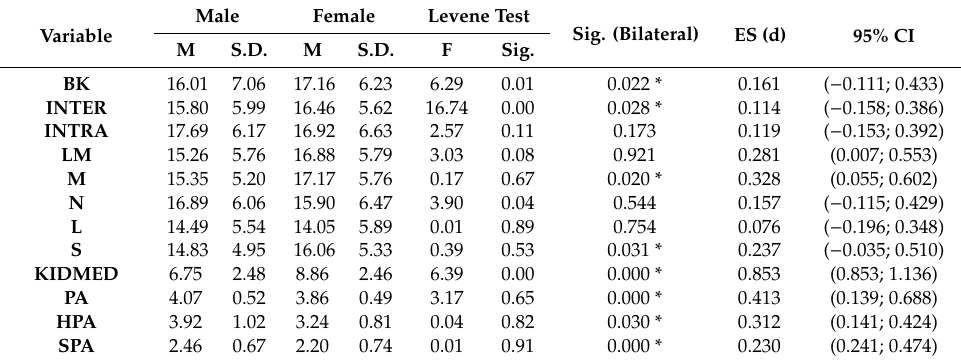
Table 1. Multiple intelligence, Mediterranean diet, and physical activity practice according to the participants’